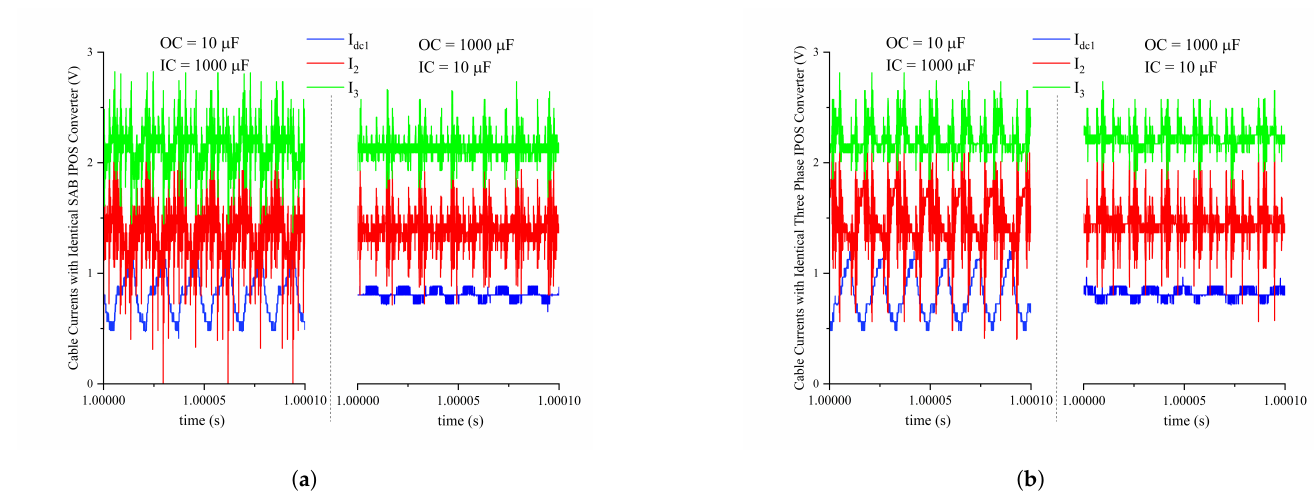
Figure 15. Comparison of the waveform of cable currents under different situations. ( a ) I dc1 , I 2 and I 3 with Identical SAB IPOS Converter; and ( b ) I dc1 , I 2 and I 3 with Identical Three Phase IPOS